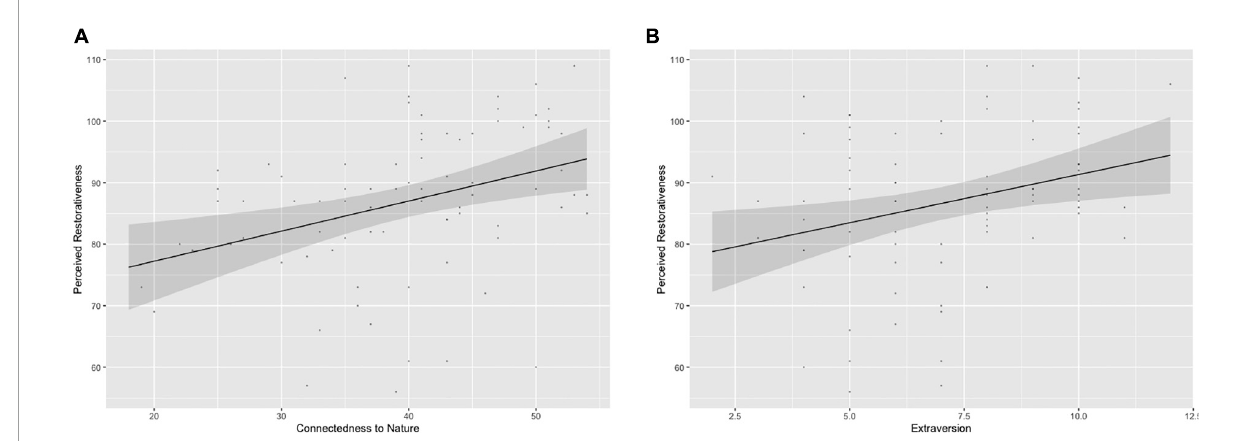
FIGURE1 Perceived restorativeness as a function of (A) connectedness to nature and (B) extraversion.